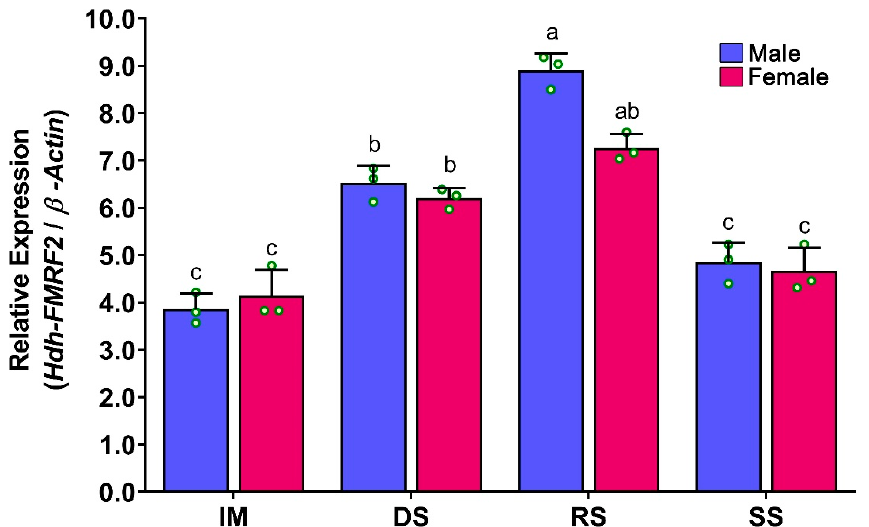
Figure 7. Relative mRNA expression levels (2 – ∆∆ CT ) of Hdh-FMRF2 (mean ± SEM) in different tissues of Pacific abalone in both sexes detected by qRT-PCR. For all bar graphs, the raw data points (green circle) represent biological replicates, the error bars represent the standard error of the mean (SEM), and different letters above the bars indicate significant differences ( p < 0.05) among organs. CG, cerebral ganglion; PPG, pleuropedal ganglion; GIL, gill; HRT, heart; DG, digestive gland; MNT, mantle; MUS, muscle; HCY, hemocyte; GND, gonad.